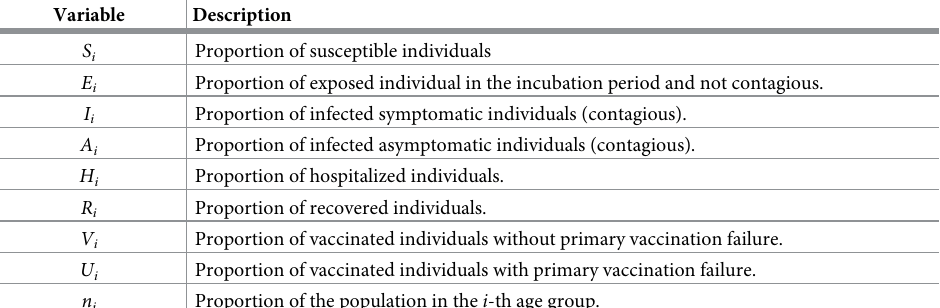
Table 1. Variables in the epidemiological model. All proportions are with respect to the initial population N 0 . The index i = 1, ... , M denotes the age group ( M = 9 in the present